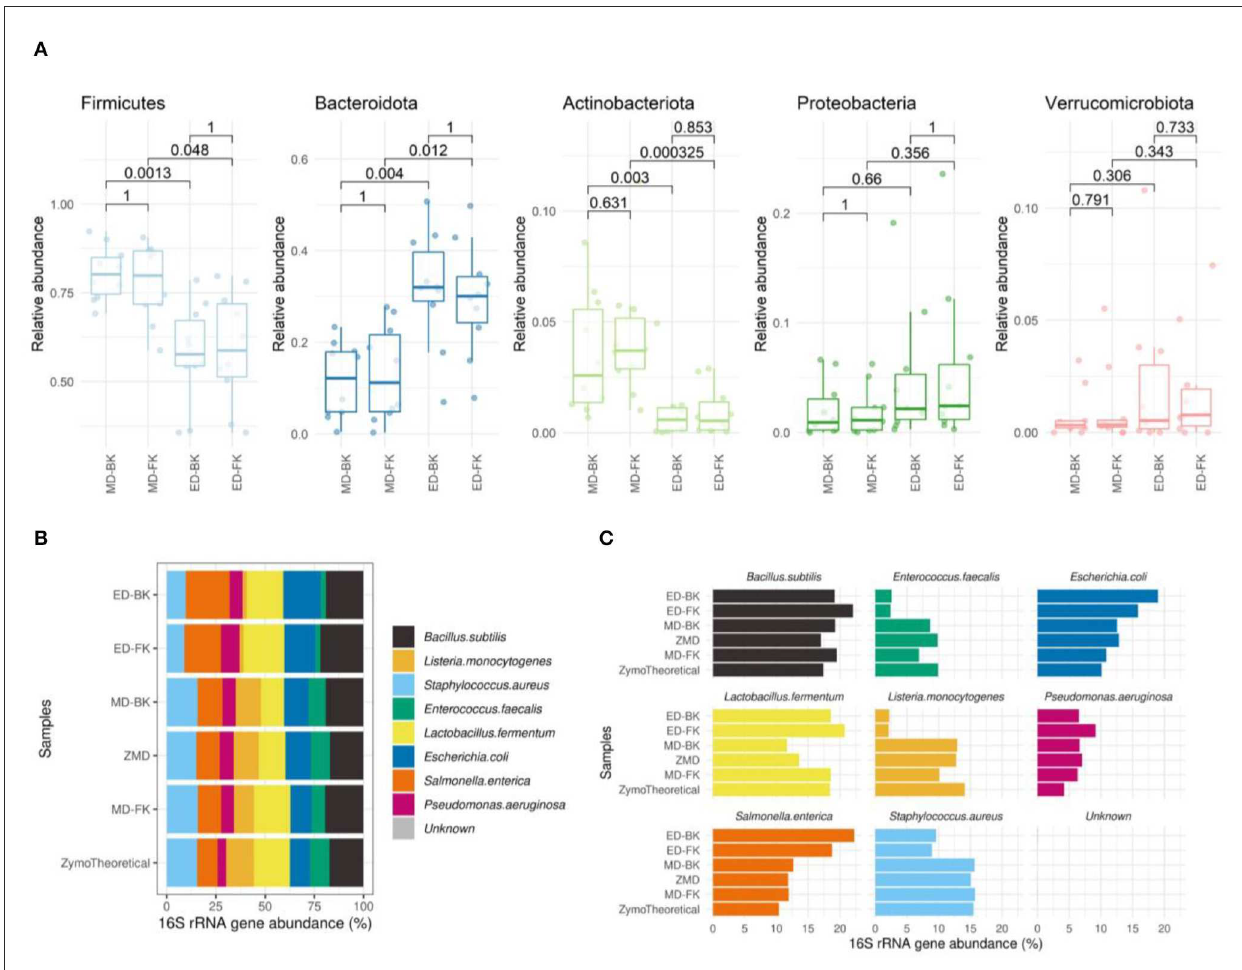
FIGURE8 (A) Boxplots show the relative abundance of the top most abundant phyla. The Wilcoxon test was used to calculate the adjusted p -values of the differences between the DNA extraction methods. (B) Spearman’s correlation of the Mock samples extracted by the different methods, compared to the theoretical composition of the Mock community sample (MD-FK rho = 0.933, ZMD rho = 0.9, MD-BK rho = 0.75, ED-FK rho = 0.633, ED-BK rho = 0.517). (C) Barplots of eight bacterial strains included in the Zymo mock